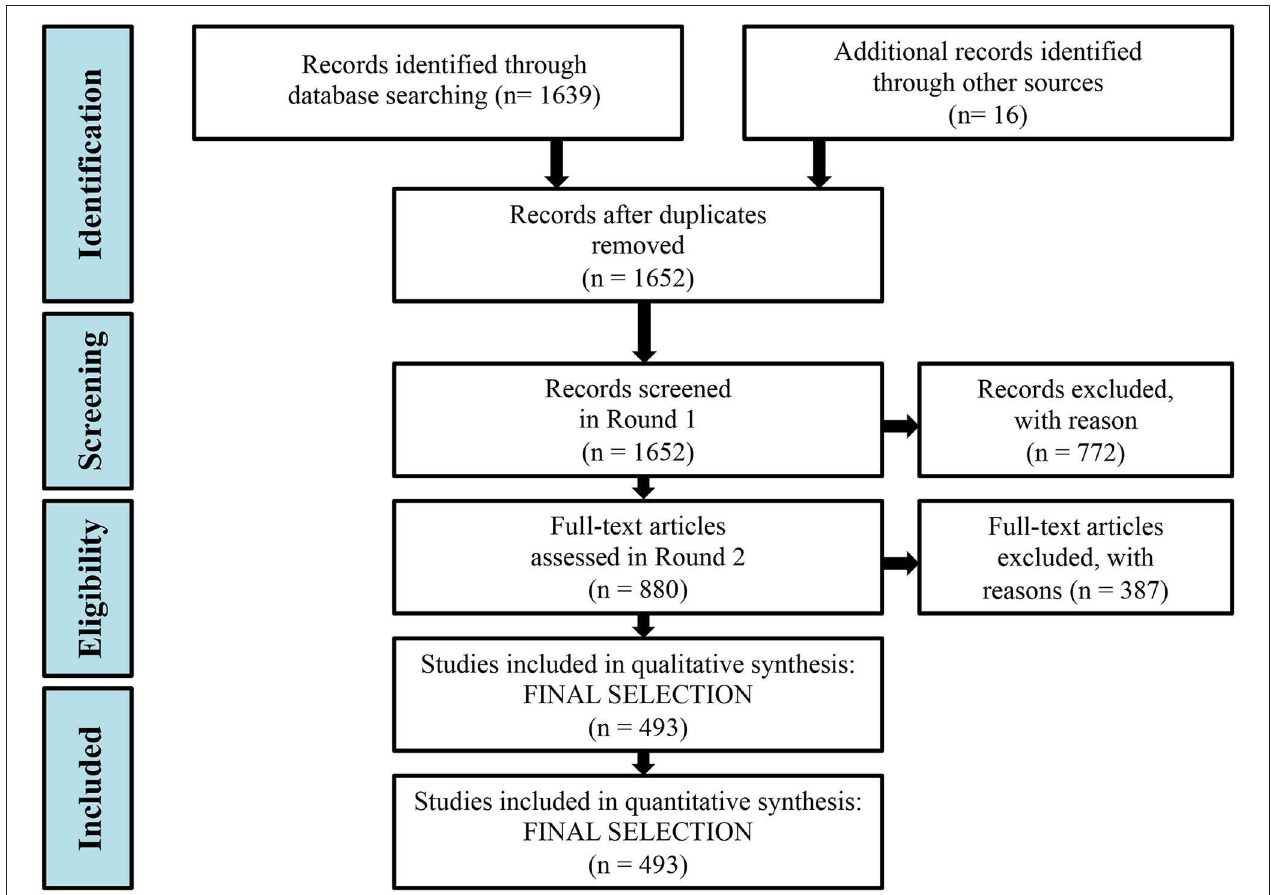
FIGURE 1 | Flow diagram of the methodology and selection processes used in this systematic review by applying the PRISMA (Preferred Reporting Items for Systematic Reviews and MetaAnalyses) methodology (Moher et al., 2010).